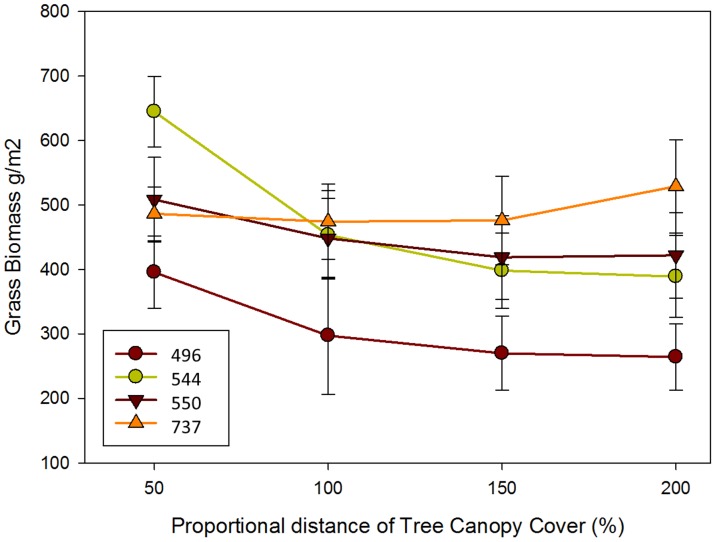
Grass biomass in each of the four MAP values replicated (corresponding to the four different study sites each replicated by four blocks) as a function of distance from the base of the tree (stem) corresponding to 50%, 100%, 150% and 200% of the tree canopy radius.Biomass values at 100% correspond to the canopy edge or drip line. Bars represent ±2 standard errors. Grass biomass is greater beneath the canopy (50% distance) compared to outside the canopy at the three drier sites, but not at the wettest site.